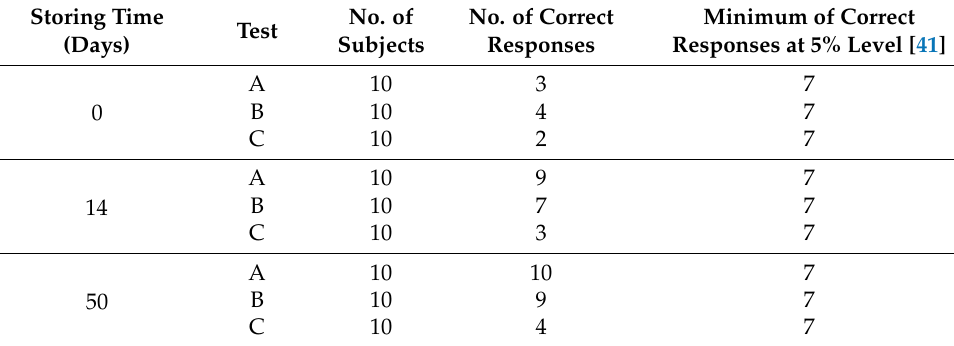
Table 2. Triangle sensory evaluation of uncoated and coated peanuts.